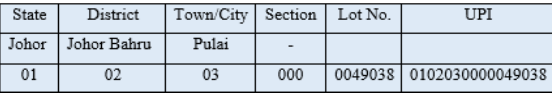
Table 1. Example of UPI code